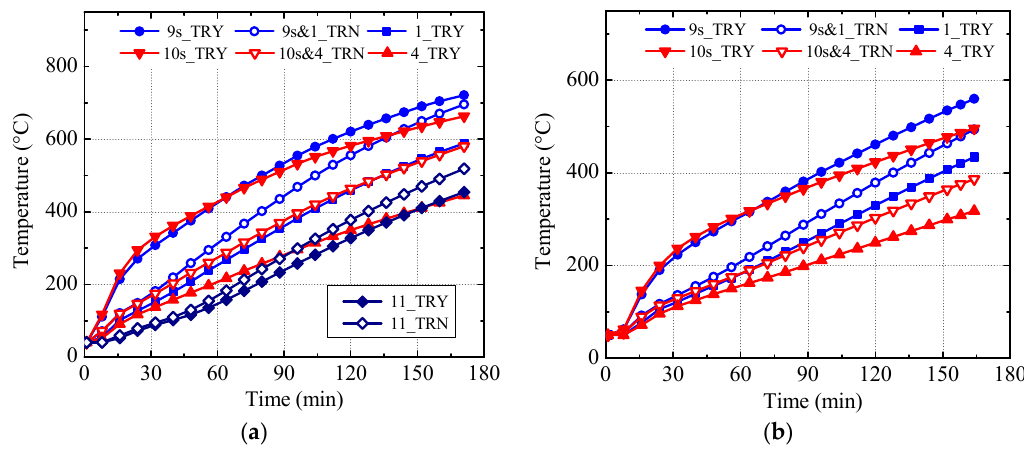
Figure 26. Effect of interface thermal resistance on temperature development: ( a ) Specimen B4 and ( b ) Specimen B5.